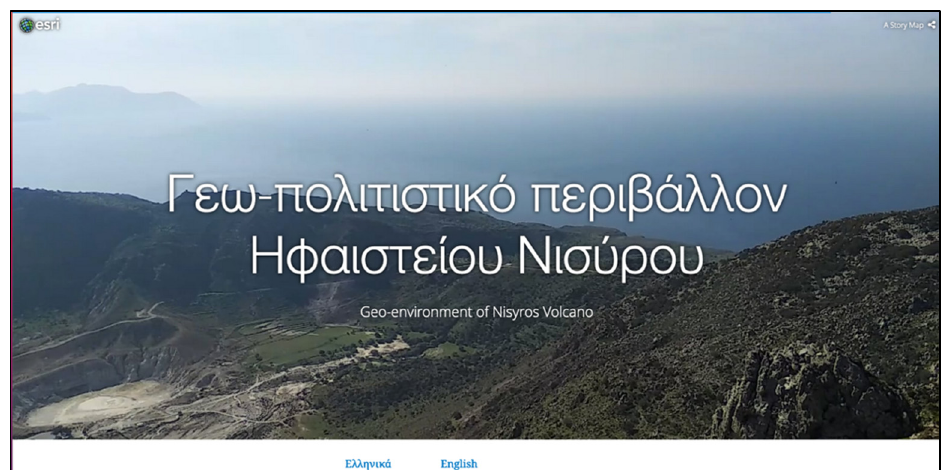
Figure 5. Screenshot showing Story Map’s home page where the title, as well as the selection between the languages, appear.